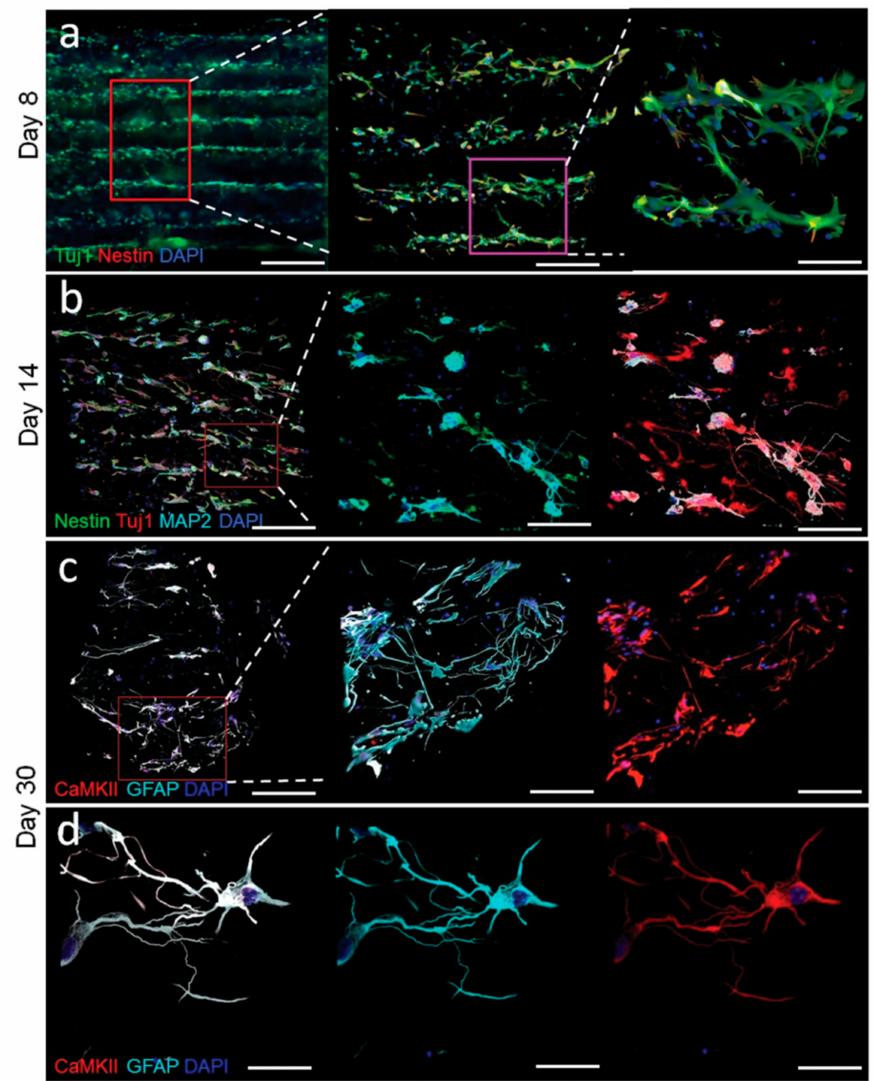
Figure 5. Patterned and in situ differentiated neurons can model the cerebral cortex. USW-based arrangement of neural progenitor cells during fibrin hydrogel cross-linking formed stable cell layers embedded in the hydrogel suitable for long-term culture without USW. This allowed for differentiation of the neural progenitor cells into neurons in situ which interacted between layers after 8 days ( a ). Fourteen days after culture, mature neuron maker MAP2 was co-expressed together with Tuj1 ( b ). The excitatory marker CaMKII and glial cell marker GFAP are detected after 30 days of culture ( c , d ). All scale bars indicate 30 µ m. Reprinted with permission from